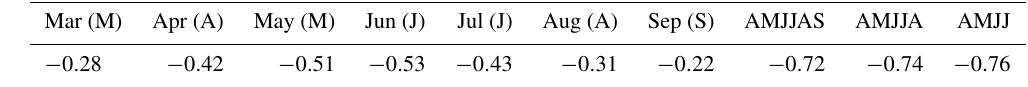
Table 2. Pearson correlation ( r ) between Beaune GHD time series and March-to-September mean Paris temperatures (1659–2018).